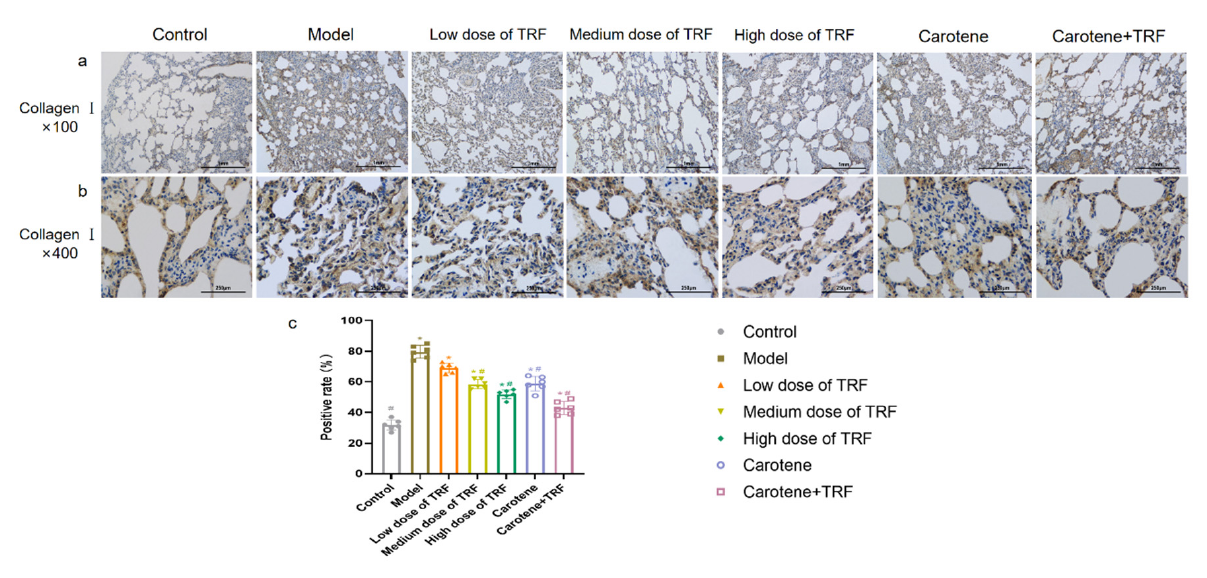
Figure 3. TRF and carotene ameliorated bleomycin-induced pulmonary fibrosis. ( a ) Representative images of IHC staining for collagen I in the lungs, with original magnification ×100; ( b ) representative images of IHC staining for collagen I in the lungs, with original magnification ×400; ( c ) quantitative analysis of the lung inflammation, n = 6. Note: compared with the CON group, # represents p < 0.05; compared with MOD group, * represents p < 0.05.